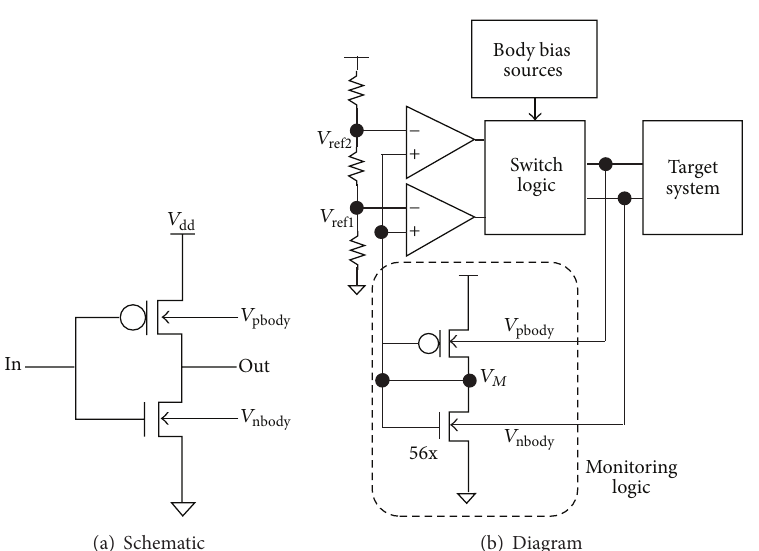
Figure 8: Adaptive 𝛽 -ratio modulation and variation tolerant body bias